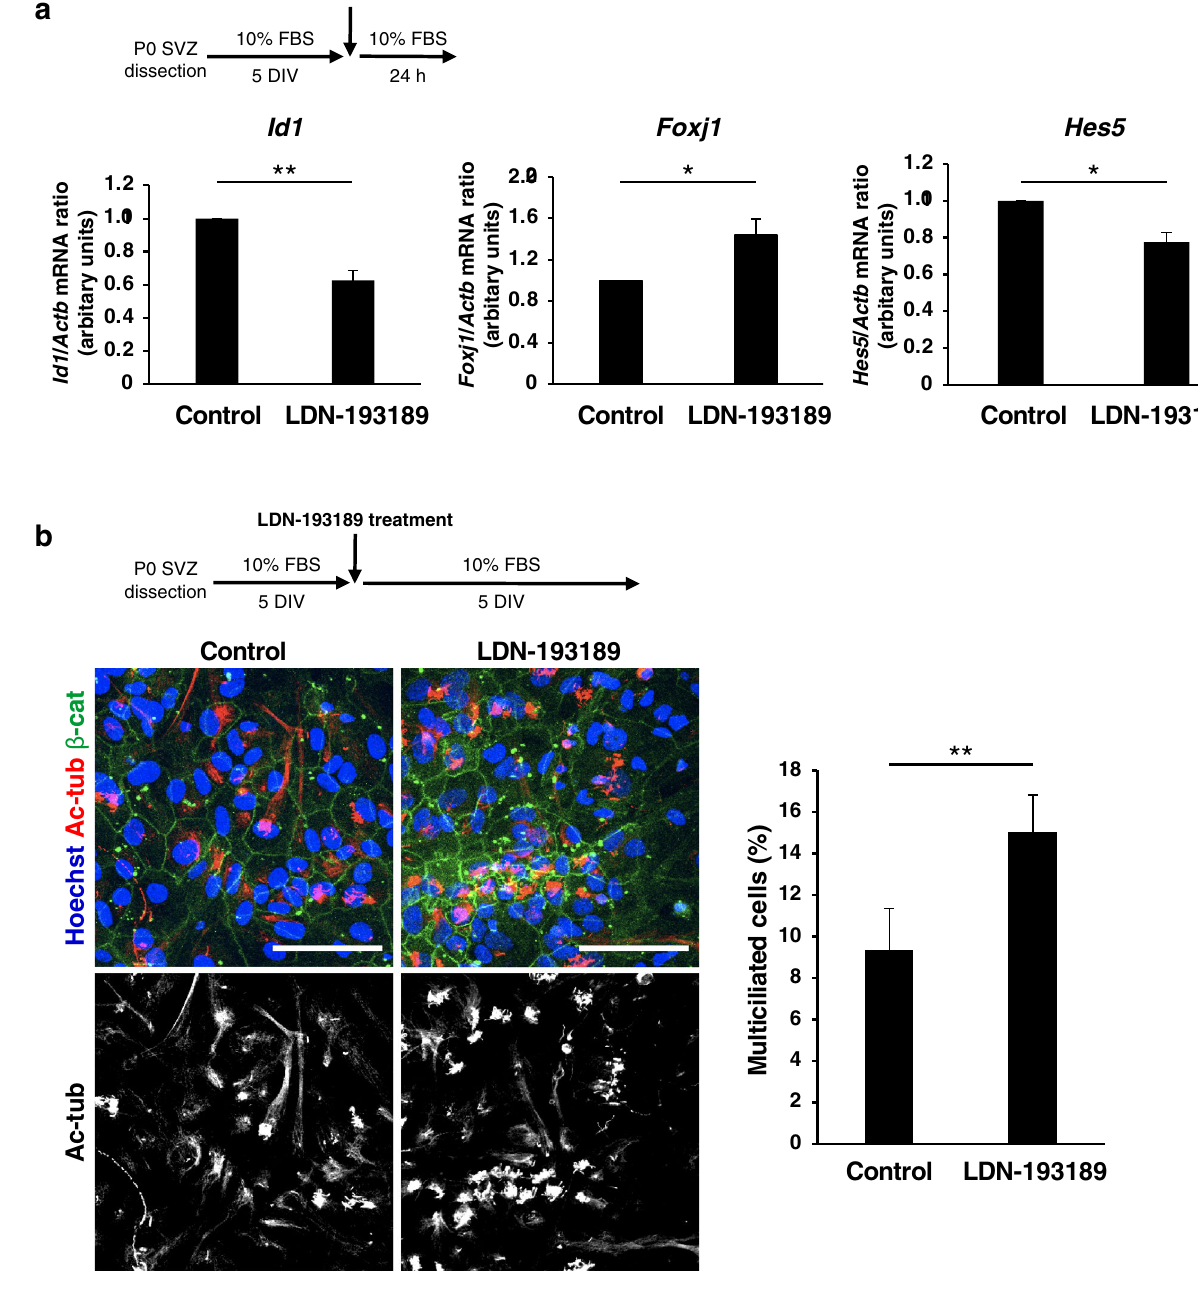
Figure 3. BMP signaling is necessary for suppression of ependymal cell differentiation in postnatal NPC cultures. ( a ) P0 NPC cultures were maintained for 5 days in the presence of 10% FBS and then for 24 h in the additional absence (Control) or presence of LDN-193189 (0.1 μM). The amounts of Id1 , Foxj1 and Hes5 mRNAs in the cells were then determined by quantitative RT-PCR analysis. Data are means ± SEM (n = 7 independent experiments). * p < 0.05; ** p < 0.01 (two-tailed Student’s paired t test). ( b ) P0 NPC cultures maintained for 5 days in the presence of 10% FBS and then for 5 days in the additional absence or presence of LDN-193189 (0.1 μM) were subjected to immunocytofluorescence staining with antibodies to Ac-tub and to β-cat. Nuclei were counterstained with Hoechst 33342. Scale bars, 50 μm. Cells with bundles of Ac-tub were counted as multiciliated cells, and their percentage was determined. Three microscope fields were counted per sample. Total of 300–500 cells were counted per sample. Data are means ± SEM (n = 3 independent experiments). ** p < 0.01 (two-tailed Student’s paired t